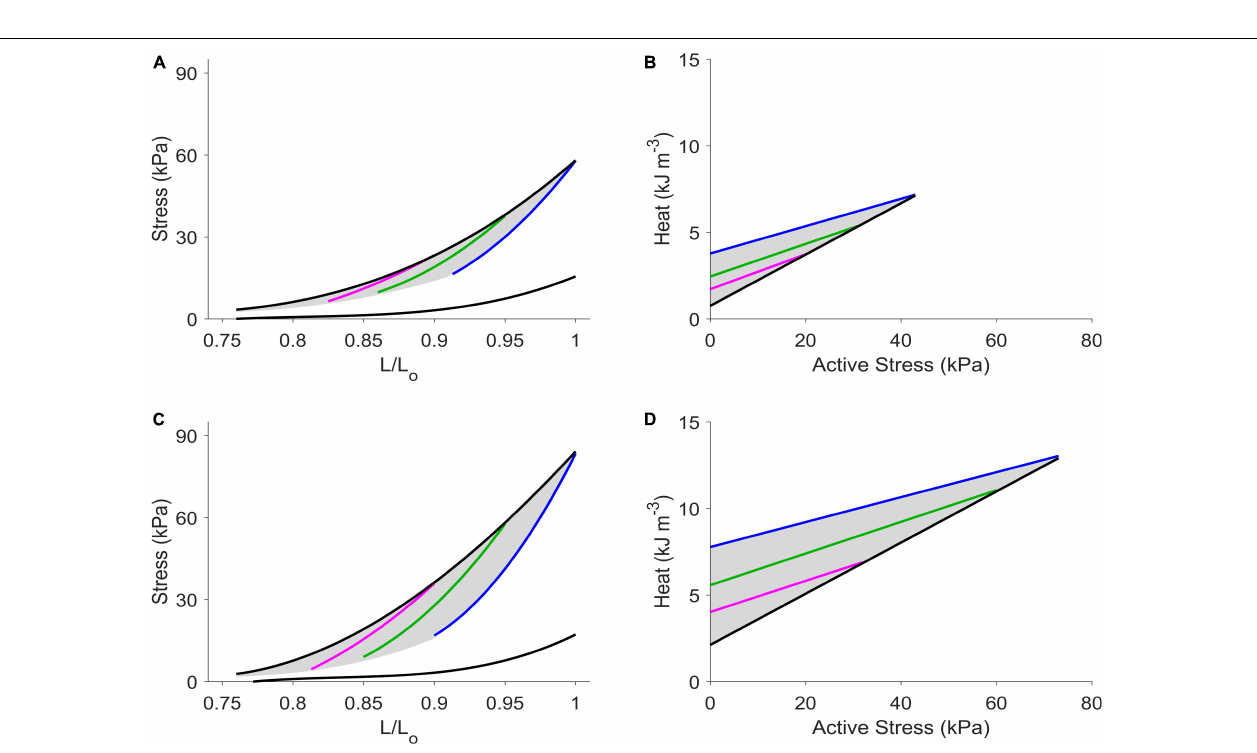
FIGURE 4 | Average regression lines from six trabeculae per group. Average lines from the Control group are presented in panels (A,B) , and those from the Isoproterenol group are depicted in panels (C,D) . Black lines denote isometric contraction. Blue, green, and magenta, respectively, denote work-loop contractions at L o , 0.95 L o , and 0.90 L o . The shaded areas in A and C denote the end-systolic zones, whereas those in B and D denote the heat-stress zones.